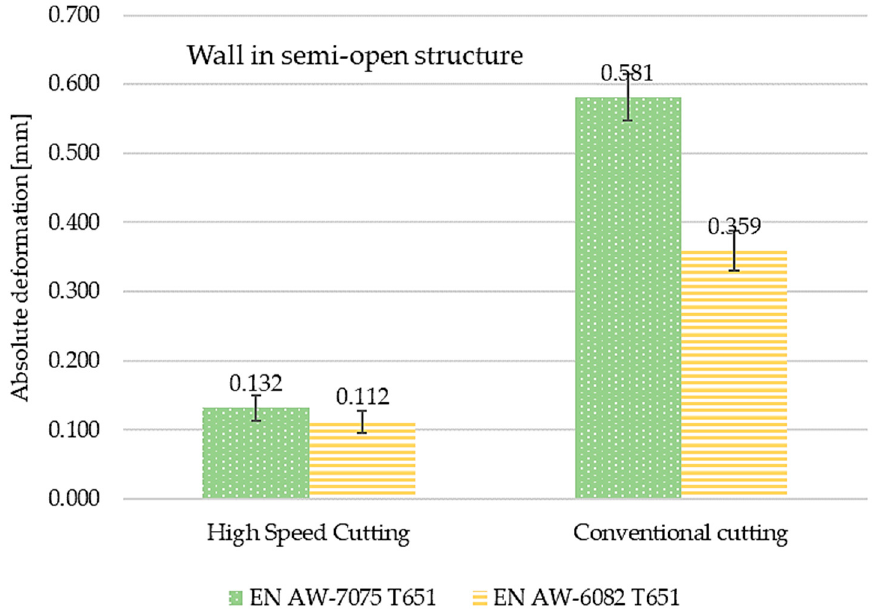
Figure 18. The comparisons of maximum absolute deformation values depending on finishing machining and material used for semi-open structures.